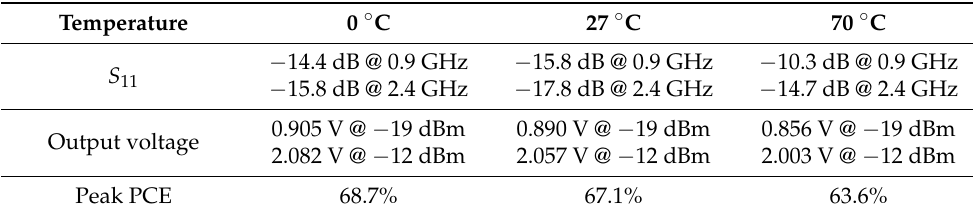
Figure 14. PCE according to RF input power at dual-band and single-band input. Table 1. Performance results at different temperatures.